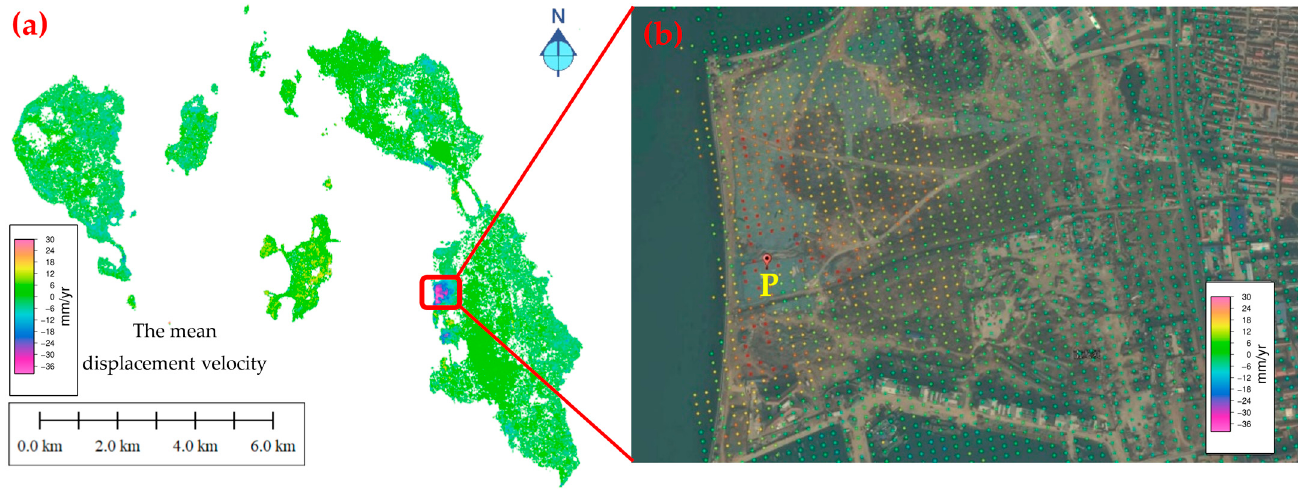
Figure 7. The cross-comparison results.